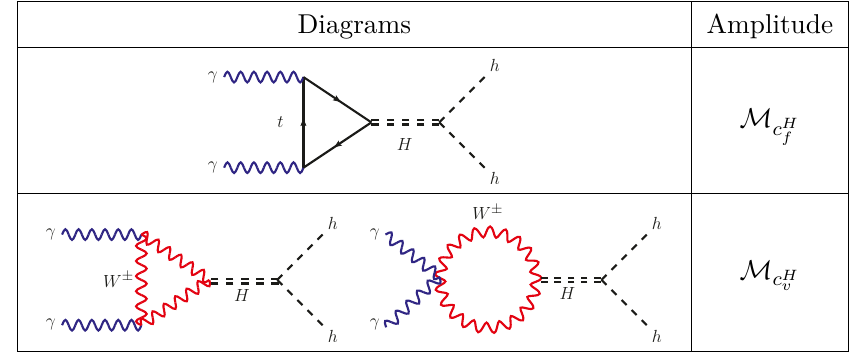
Table 4 . Additional diagrams with the heavy scalar H , with the corresponding partial amplitudes as defined in the text.